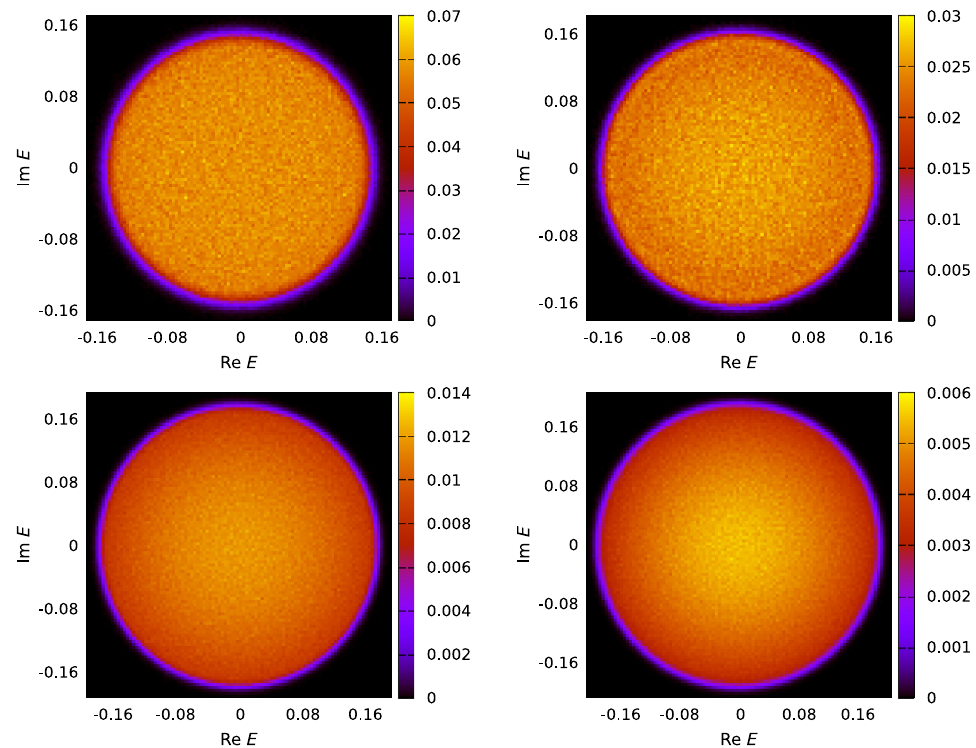
FIG. 3. Spectral density associated with the complex eigenvalues of the nHSYK Hamiltonian of Eq. (1) for q ¼ 4 and N ¼ 18 (top-left panel), 20 (top-right panel), 22 (bottom-left panel), and 24 (bottom-right panel). As in the previous cases, the average spectral density is radiallysymmetric,but,unlikethe q ¼ 3 case,itisratherunstructured,withabroadmaximumlocatedinthecentralpart,followedbyaslow decayforlarger j E j energies.Finally,asisthecasefor q ¼ 3 ,arathersharpedgeisobservedwherethedensityvanishesabruptly.Becauseof the absence of inversion symmetry, the spectral density is not suppressed or enhanced in the j E j ∼ 0 region, as was the case for q ¼ 3